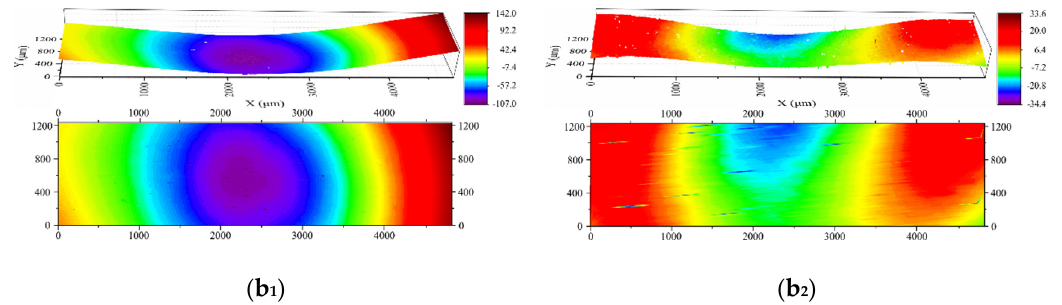
Figure 8. Evolution of surface topography of the indented foam samples. ( a 1 ) After indentation with a conical indenter; ( a 2 ) upon heating at 100 ° C for 5 min; ( b 1 ) after indentation with a spherical indenter; ( b 2 ) upon heating at 100 ° C for 5 min.